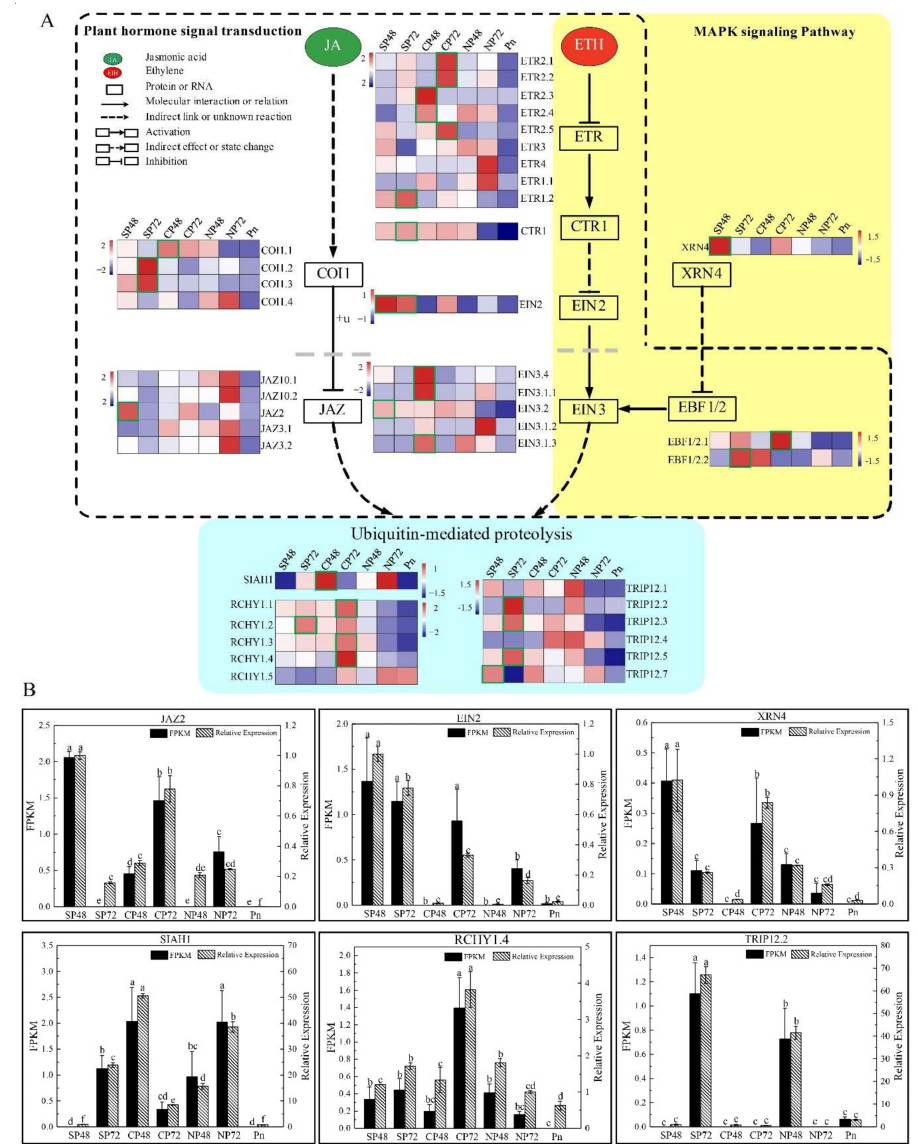
Figure 4. Metabolic pathways involved in self-incompatibility of Camellia oleifera . ( A ) Expression levels of each transcript in self-, cross- and non-pollinated pistils and mature pollen were shown by heatmap using log10(FPKM). FPKM = fragments per kilobase per million mapped fragments. The dotted line represents plant hormone signal transduction, the yellow background represents the plant MAPK signaling pathway and the blue background represents the ubiquitin-mediated proteolysis. The rectangles marked with green frames represent transcripts with significant differences in SP48_VS_CP48 or SP72_VS_CP72 by Duncan’s test. SP48 / 72, self-pollinated pistils at 48 h / 72 h; CP48 / 72, cross-pollinated pistils at 48 h / 72 h; NP48 / 72, non-pollinated pistils at 48 h / 72 h and Pn, mature pollen. COI1: coronatine insensitive 1 ( COI1.1 : cb10019_c10797 / f1p1 / 2331, COI1.2